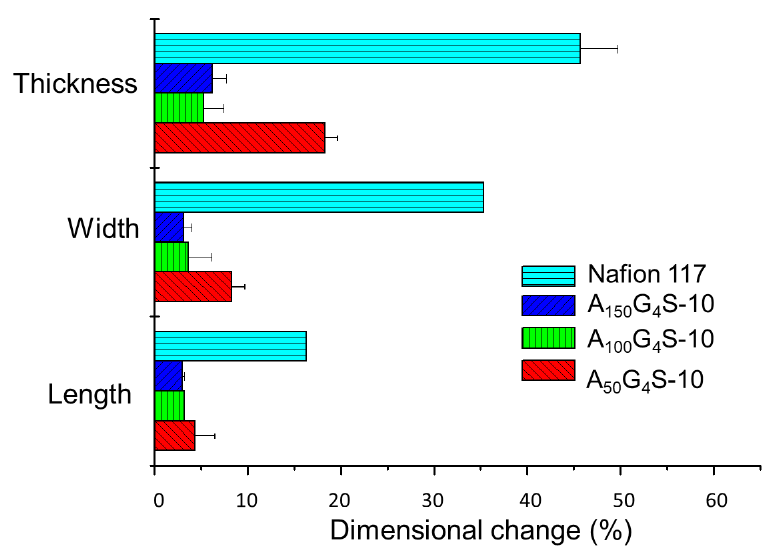
Figure 8. Dimensional stability of the cross-linked diblock ionomer membranes in pure ethanol (20.6 M). A Nafion 117 membrane is included for comparison.